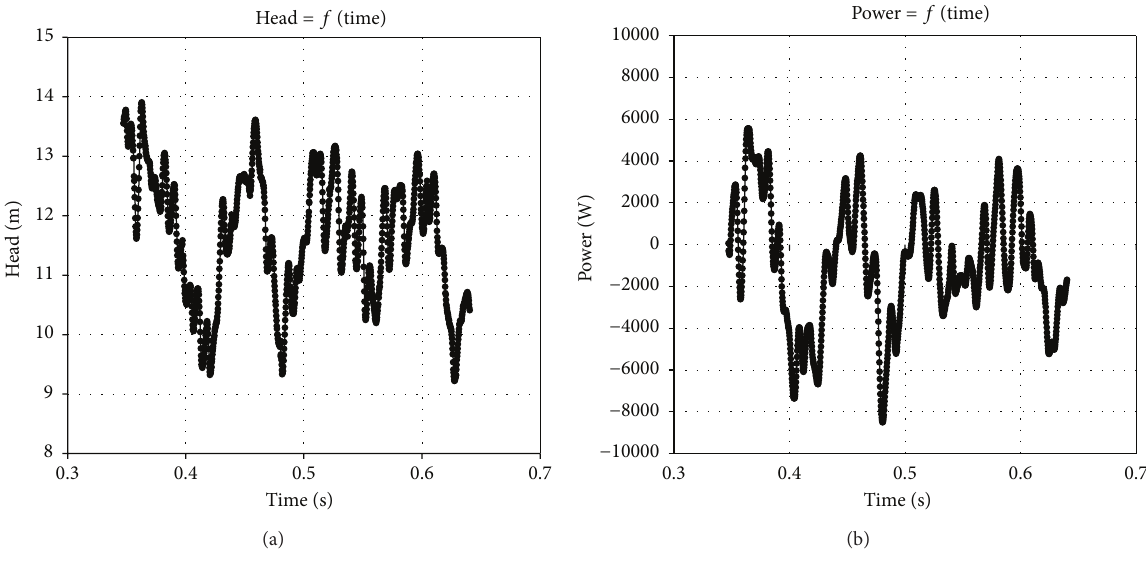
Figure 8: Time evolutions of head and power for an unsteady computation—operating point: − rpm /𝑄 = −0.6𝑄 𝑛 .